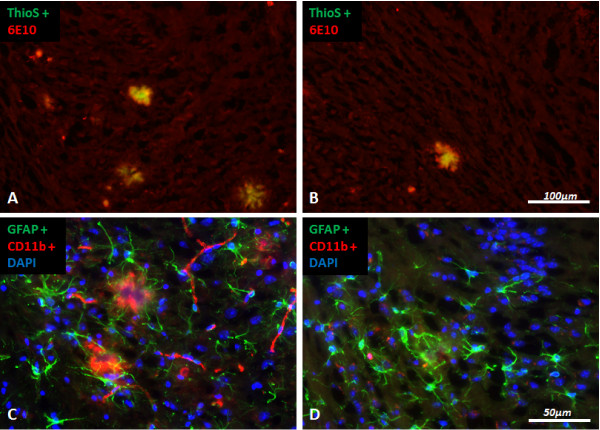
Chronic daily exposure to EVP-0015962 in Tg2576 mice reduces Aβ deposition and reactive gliosis. Representative sections illustrating staining of amyloid plaques with ThioflavinS (green) and by immunohistochemistry (6E10, red) in the subiculum of the hippocampus from Tg2576 mice fed either a control diet (A) or treated with 20 mg/kg/day of EVP-0015962 (B). Representative sections illustrating immunohistochemical staining of reactive astrocytes (GFAP, green) and activated microglia (CD11b, red) in the subiculum from Tg2576 mice, fed either a control diet (C) or treated with 60 mg/kg/day of EVP-0015962 (D). Nuclei are stained with 4',6-diamidino-2-phenylindole (DAPI, blue). In C, amyloid deposits are visualized by the presence of interspersed fine microglial processes and are surrounded by activated microglia and in turn by GFAP-positive astrocytes.